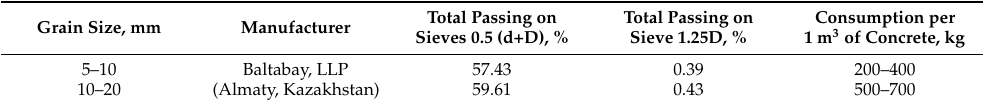
Table 4. Characteristics of crushed stone [21].